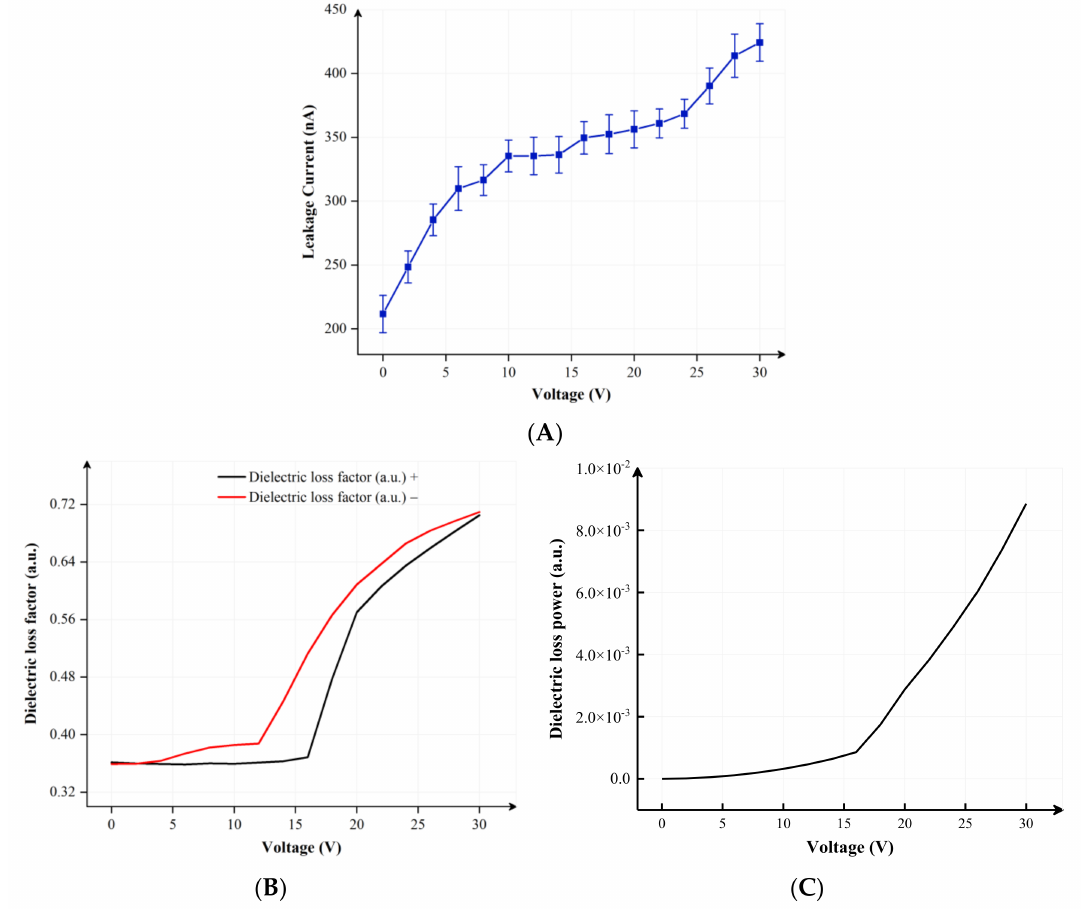
Figure 4. Measurement of performance parameters for EFDs. ( A ) The change curve of leakage current in EFDs. The measurement rate was 2 V/s. Error bars were obtained by repeating the experiment three times. ( B ) The dielectric loss factor curve of EFDs within 500 ms. The black line and the red line represented the rising curve and the falling curve, respectively. ( C ) Luminance curves of dielectric loss power in different V . The dielectric loss power was positively correlated with V max , and it changed in real time with V